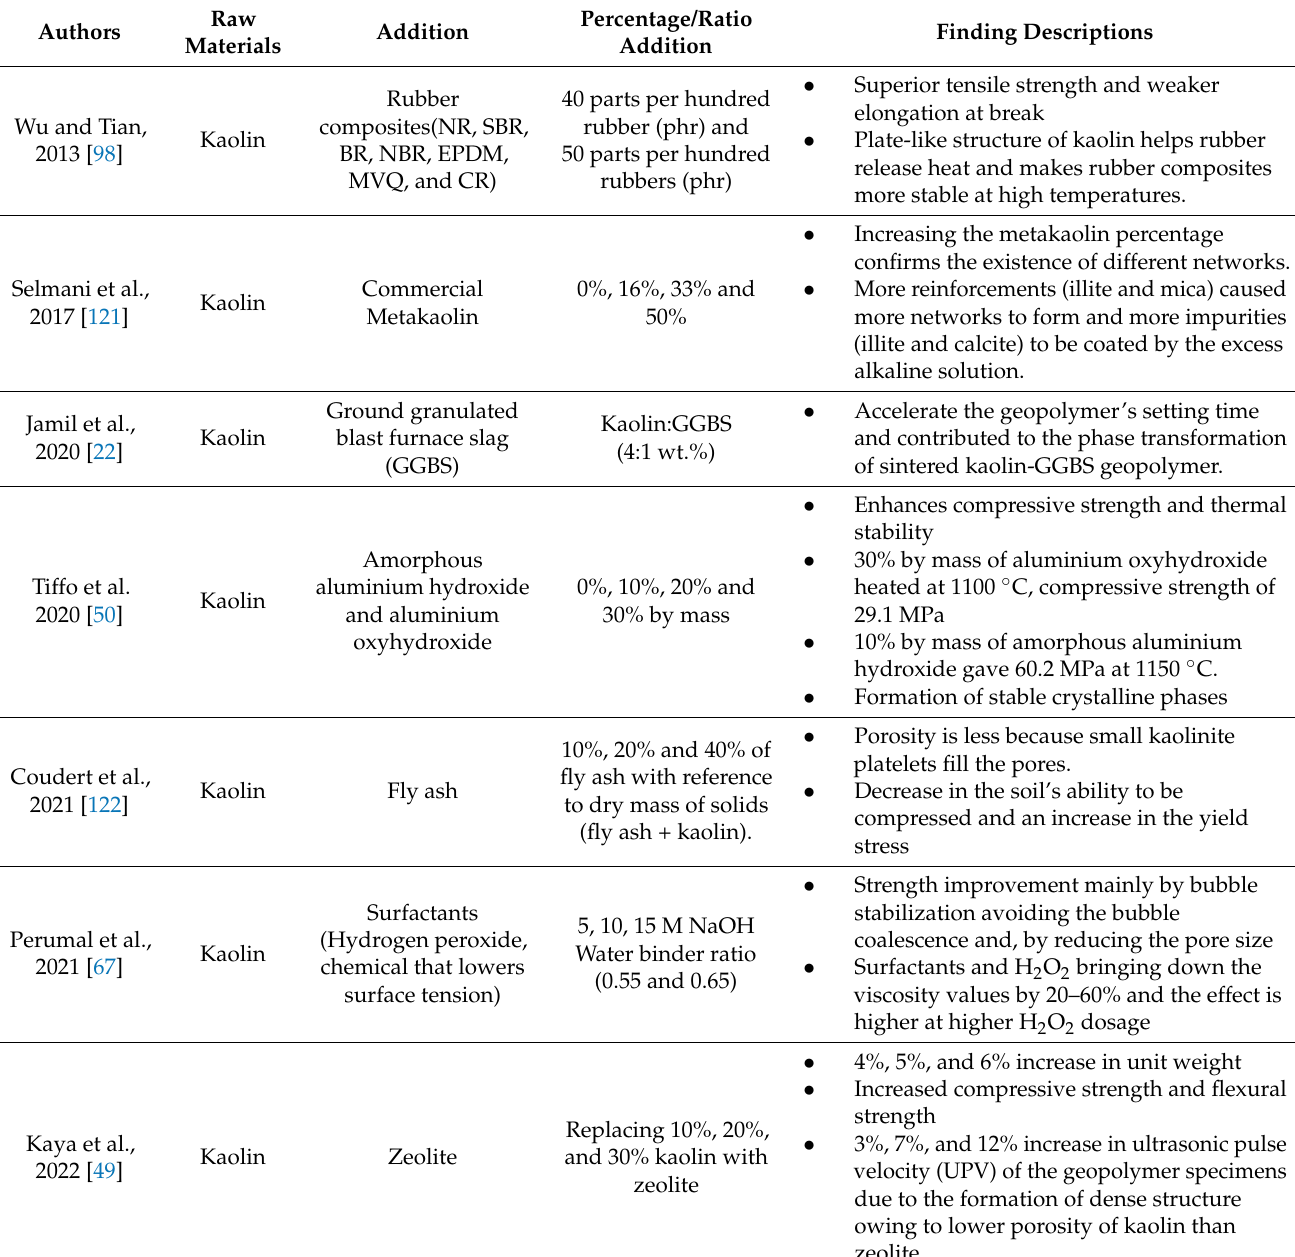
Table 8. Addition as a reinforcement in ceramic